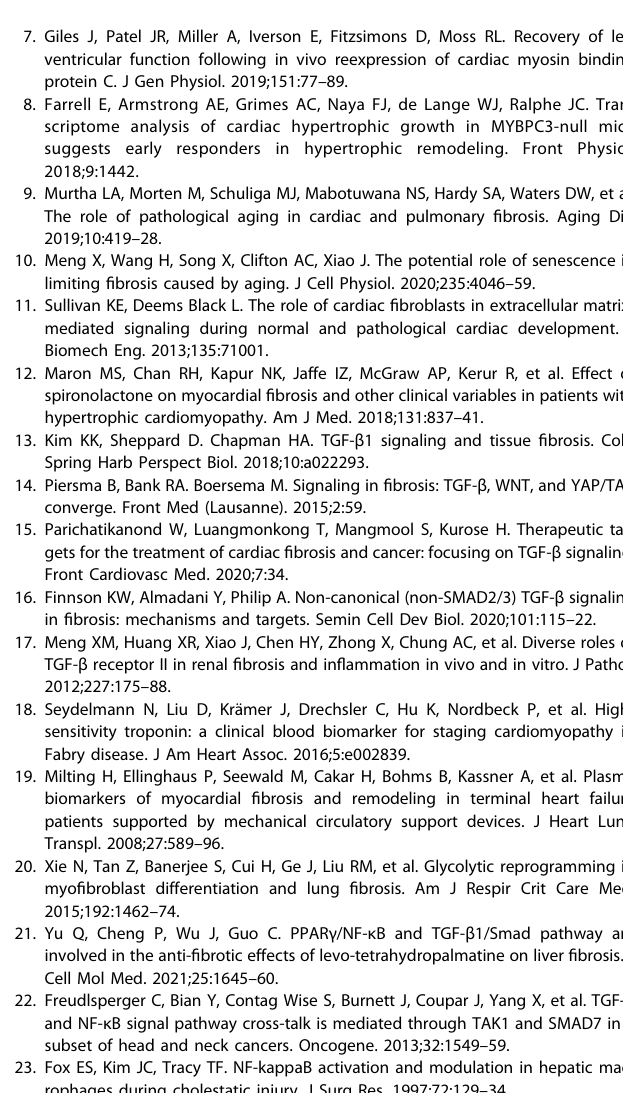
Fig. 7 MYBPC3 de fi ciency up-regulated NF- κ B/TGF- β 1/HIF-1 α /aerobic glycolysis signaling cascade in cardiac fi broblasts, contributing to HCM myocardial fi brosis. MYBPC3 de fi ciency activated NF- κ B signal pathway, which increased TGF- β 1, HIF-1 α , and aerobic glycolysis signal, leading to premature myocardial fi brosis in